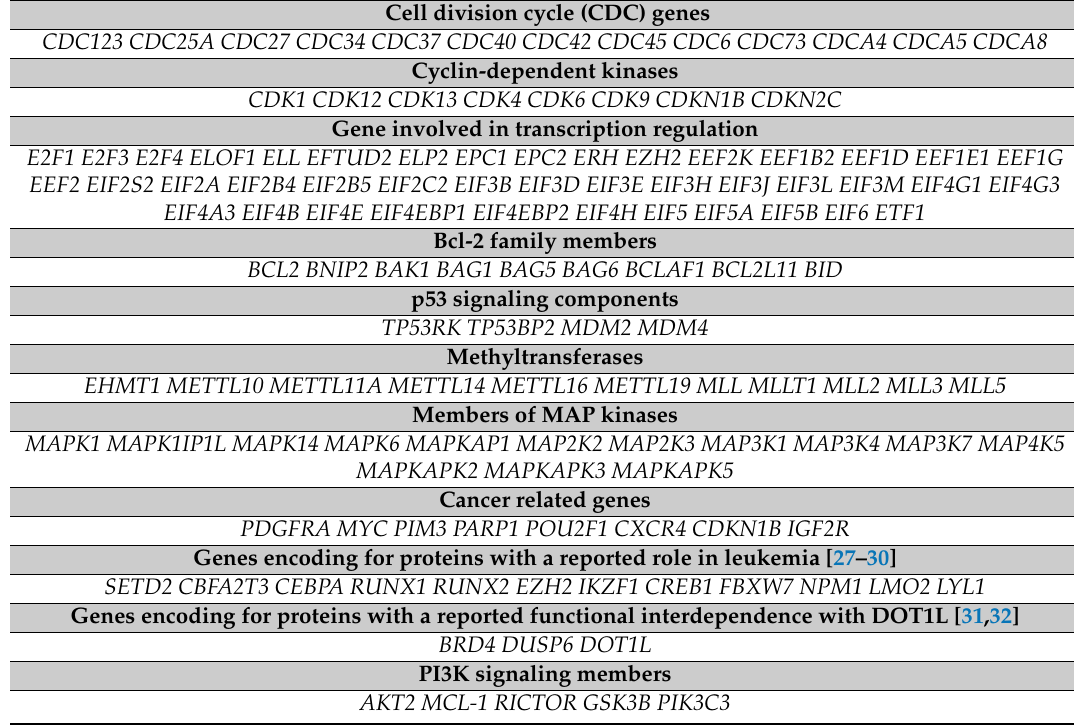
Table 1. Selected DOT1L target genes with major roles in cell proliferation and